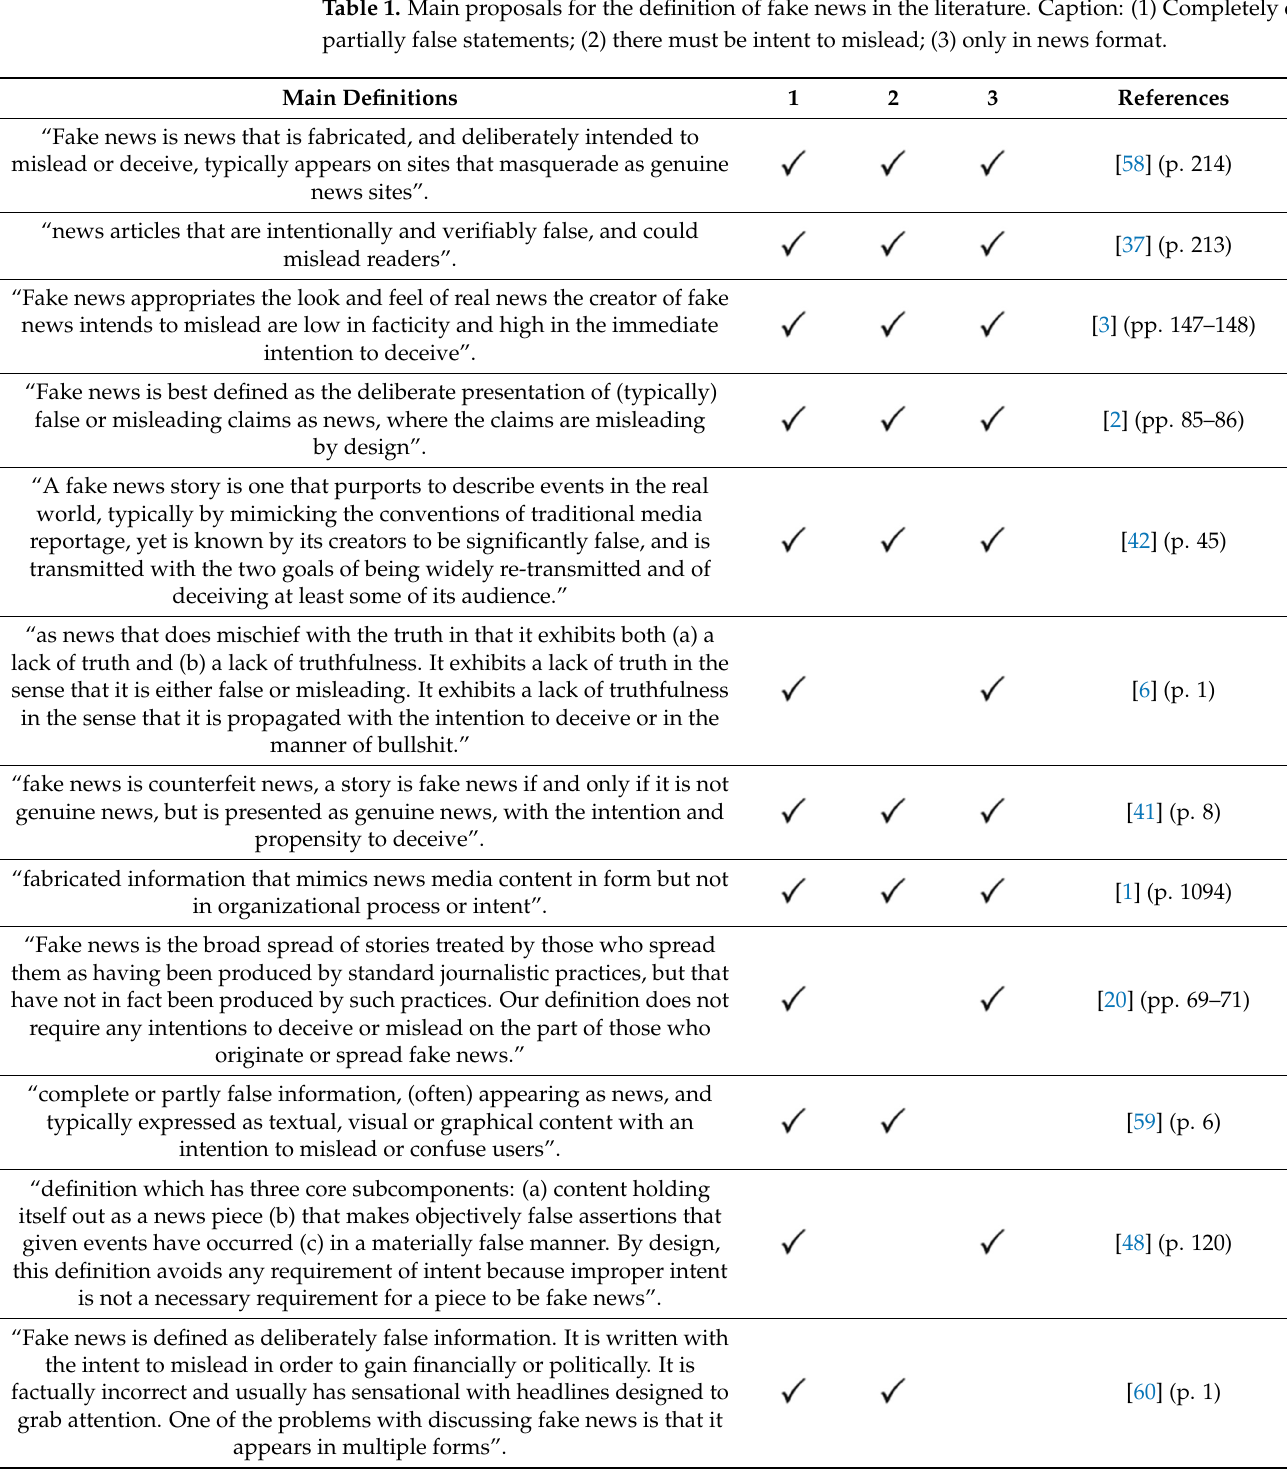
Table 1. Main proposals for the definition of fake news in the literature . Caption: (1) Completely or